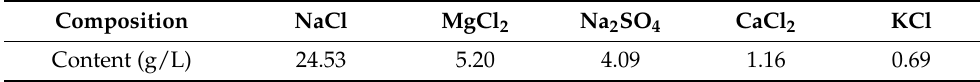
Table 2. Chemical composition of the seawater